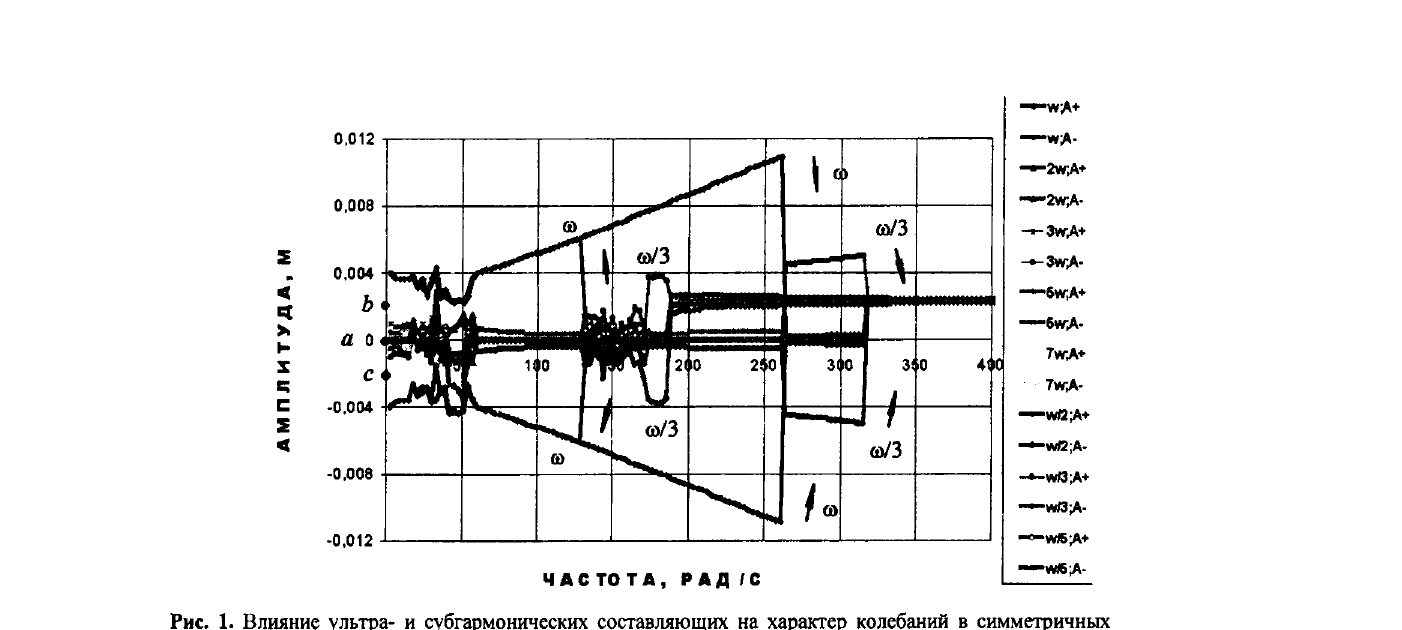
Fig 1. Influence of ultra and subharmonic elements on the character of oscillations in symmetrical